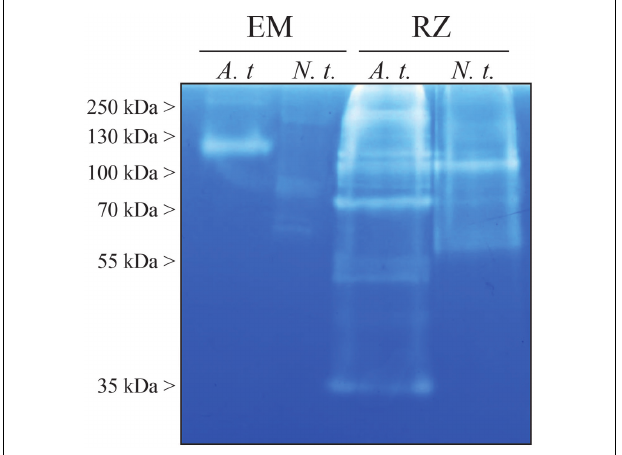
FIGURE 1 | Proteolytic activities analyzed by gelatin zymography of the extracellular media (EM) and the rhizosecretomes (RZs) of Arabidopsis thaliana (A.t.), and Nicotiana tabacum (N.t.). Samples were collected from 7-days-old suspension cells (EM) or 7-weeks-old hydroponic cultures (RZ). 20 μ l of EM or RZ were loaded on a SDS polyacrylamide gel containing 0.05% of gelatin. After electrophoresis, proteins were renaturated in the gel and the proteolytic activity was revealed after a 16-h incubation required for gelatin degradation.The presented result is representative of two independent